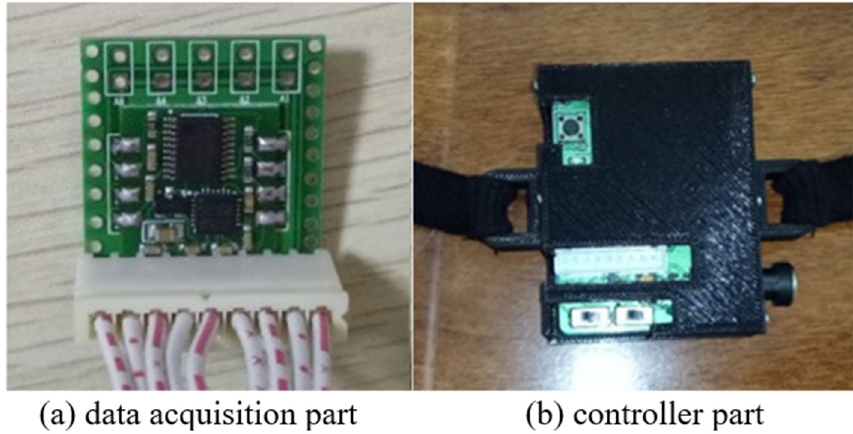
Figure 5. DN-1 composition of data glove module.